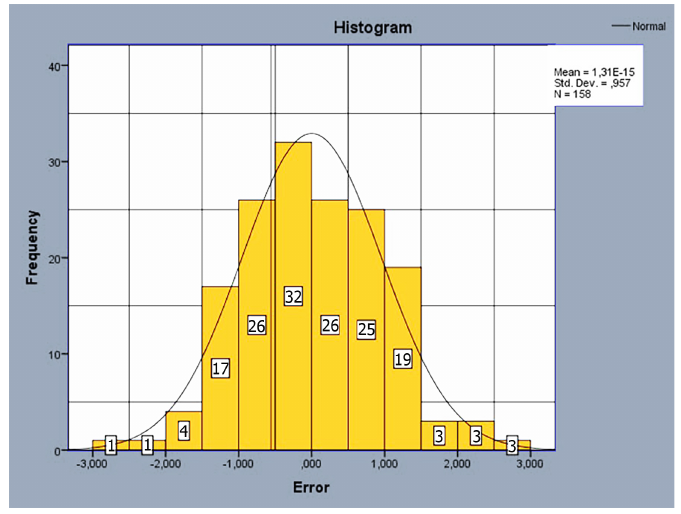
Fig. 5. Histogram of errors resulting from modelling with GLAR